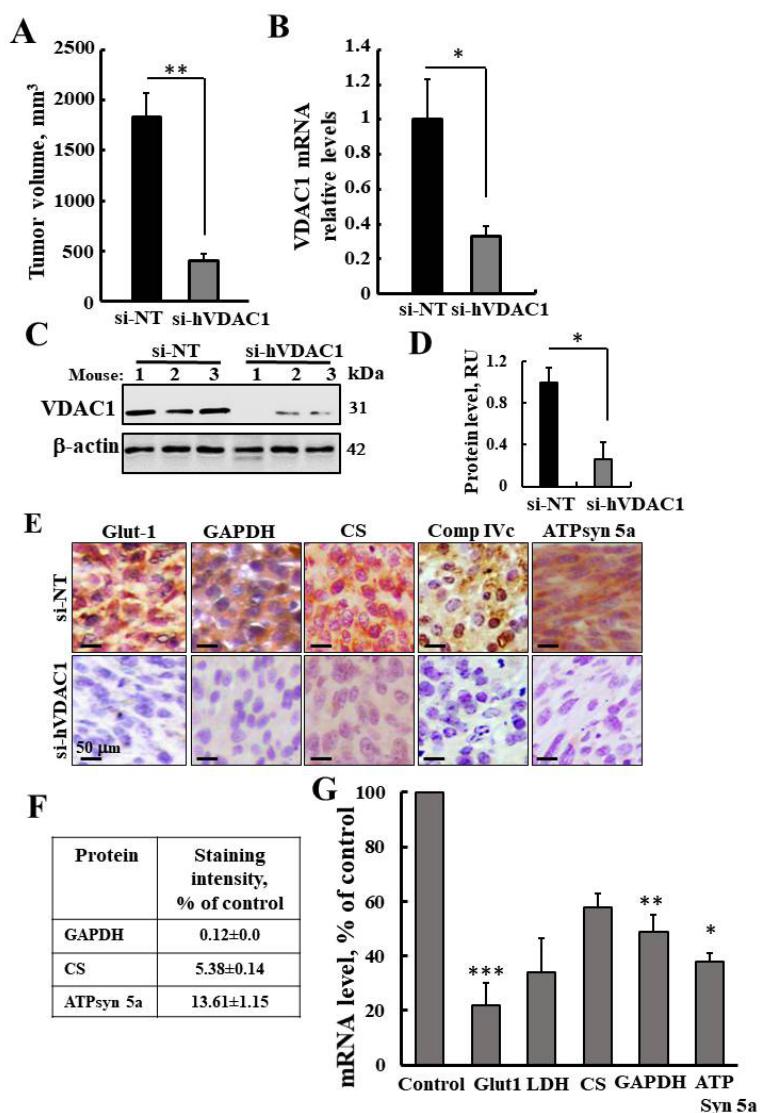
Figure 1. VDAC1 depletion by specific si-RNA inhibits tumor growth and reprogrammed metabolism of U-87-MG cell-derived tumors. ( A ) U-87-MG cells were inoculated subcutaneously into nude mice (3 × 10 6 cells/mouse). When the tumor volume reached 60–100 mm 3 , the mice were divided into two groups (five mice per group) and treated with non-targeted siRNA (si-NT) or human VDAC1-specific si-RNA (si-hVDAC1) by intratumoral injection (every 3 days) to a final concentration of 75 nM per tumor. The calculated average tumor volume (means ± SEM, ** p < 0.01) are presented in mm 3 . ( B , C ) VDAC1 mRNA expression levels in si-NT-TTs and si-hVDAC1 were analyzed by qRT-PCR (B) or immunoblotting (C). ( D , E ) Expression of selected metabolism-related proteins (Glut1, GAPDH, citrate synthase (CS), complex IV, and ATP Syn5a), as analyzed by immunohistochemical (IHC) staining using specific antibodies (D) and qRT-PCR-assessed mRNA levels (E) of si-NT- or si-hVDAC1-TTs. p < 0.001 (***), p < 0.01 (**), p < 0.05 (*).